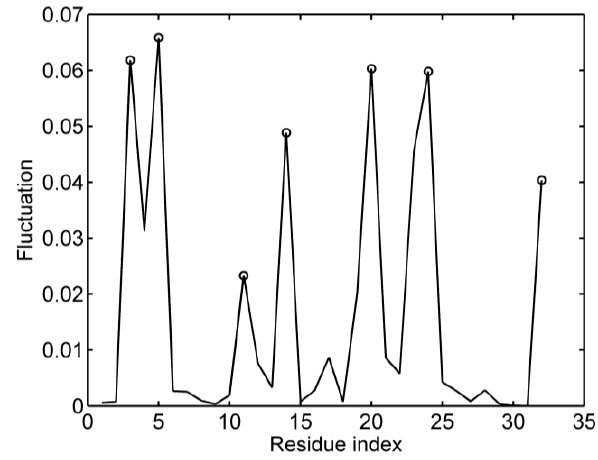
Figure 3. The fastest five mode shapes of the Sp1f2. There are several peaks marked in the curve that correspond to the kinetically key